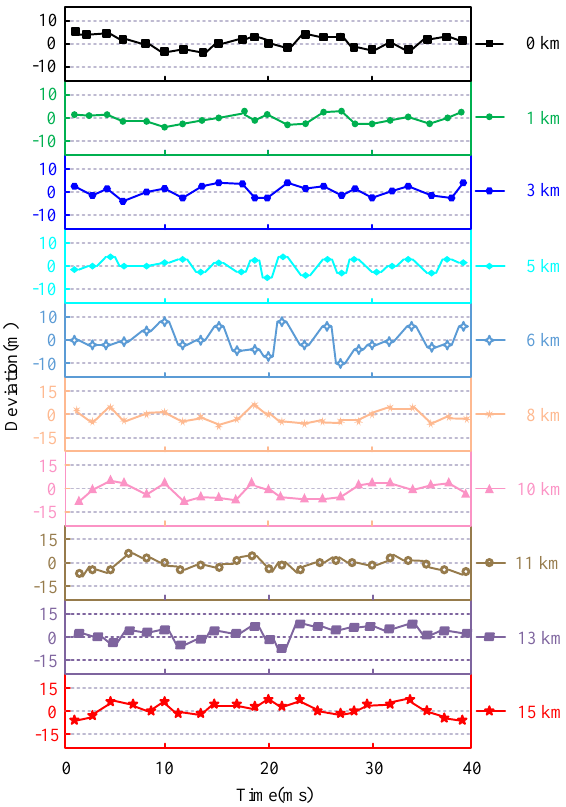
Figure 11. Positioning deviation curve of different positions.